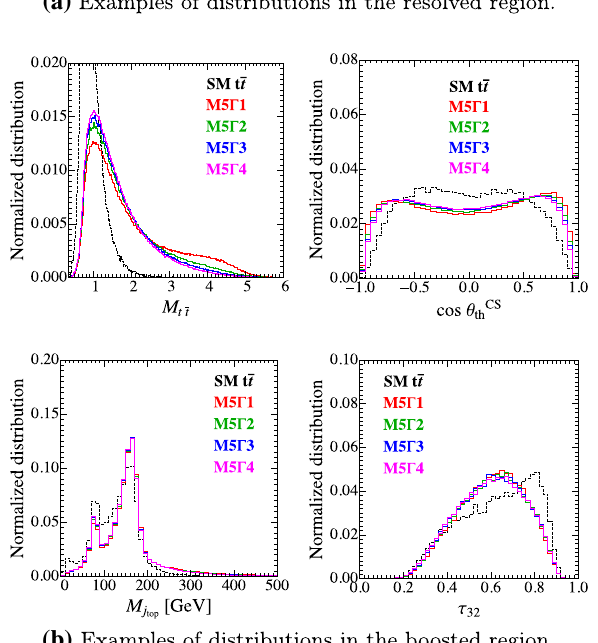
Fig. 4 Distributions of high-level observables in the a resolved and b boosted regions. We use these to train a new set of DNNs to test whether